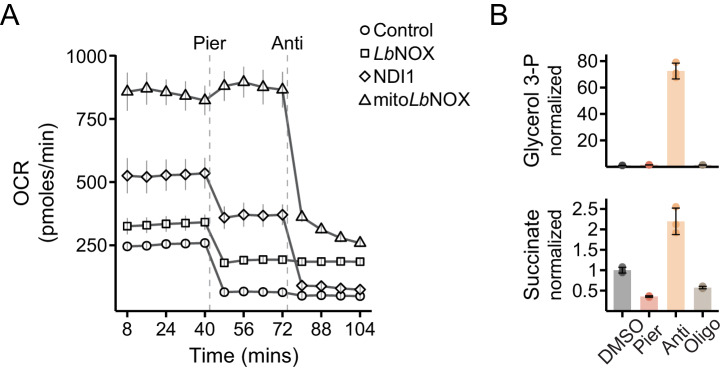
Additional data on bioenergetics and metabolism in myoblast cell lines.(A) Oxygen consumption rate (OCR) of control, LbNOX, mitoLbNOX or NDI1 cells sequentially treated with piericidin and antimycin. Mean ± SD, N = 4–5. (B) Peak intensities of glycerol 3-phosphate and succinate in extracts of control cells treated with inhibitors for 1 hr. Data is normalized to DMSO. Mean ± SD, N = 3.